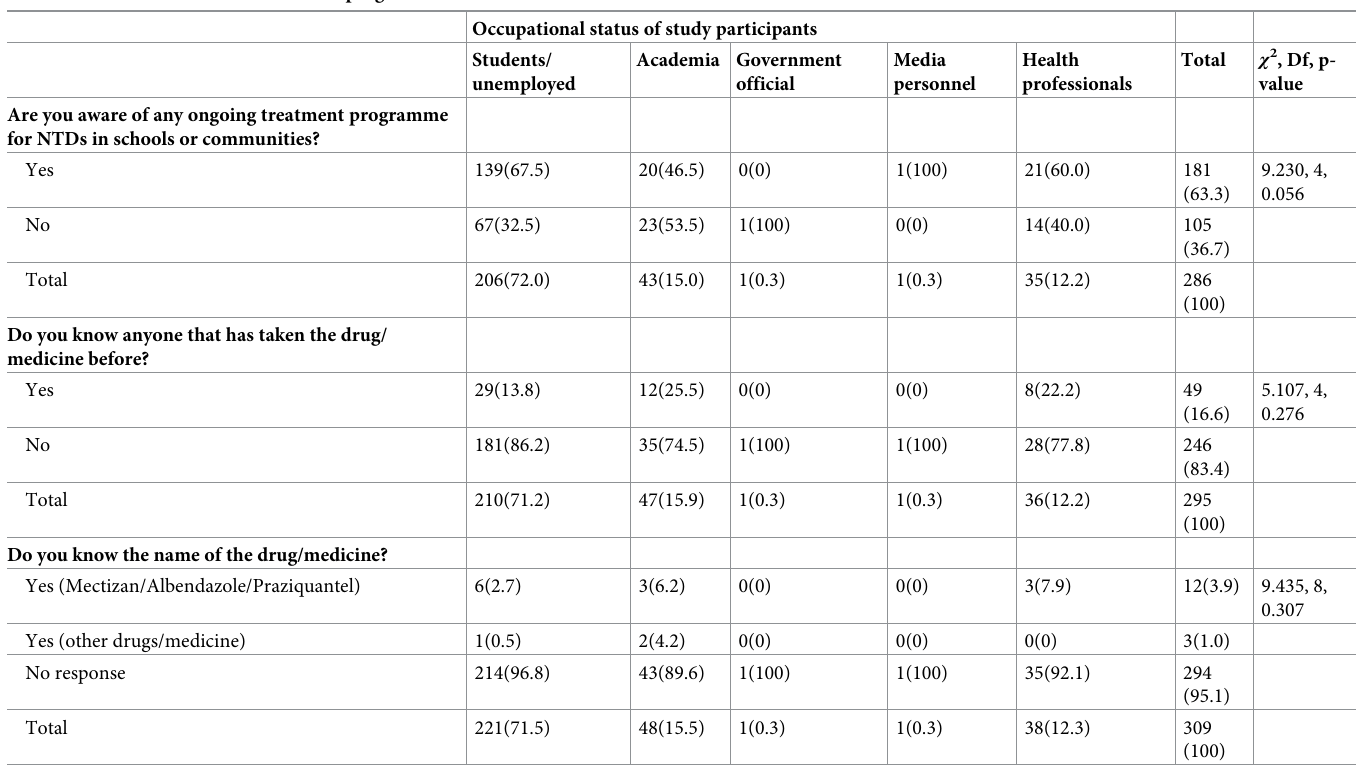
Table 4. Awareness about NTDs control programme in schools and